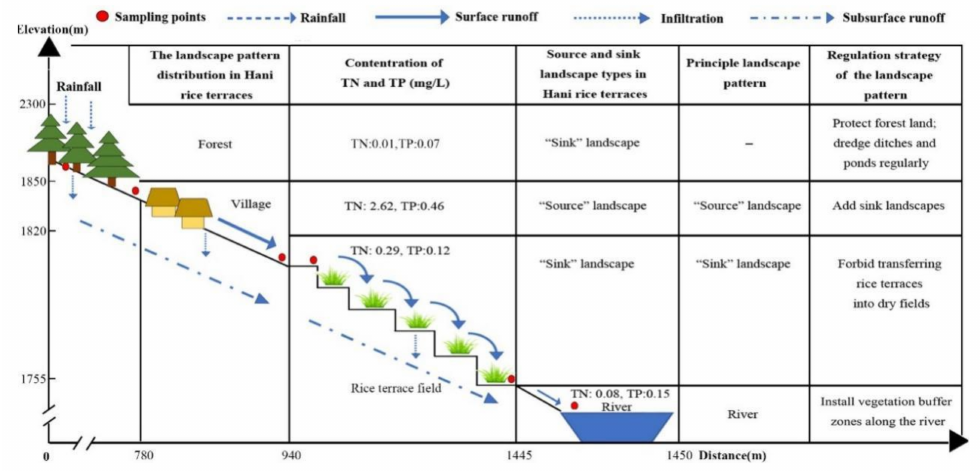
Figure 5. The vertical landscape pattern in the Hani rice